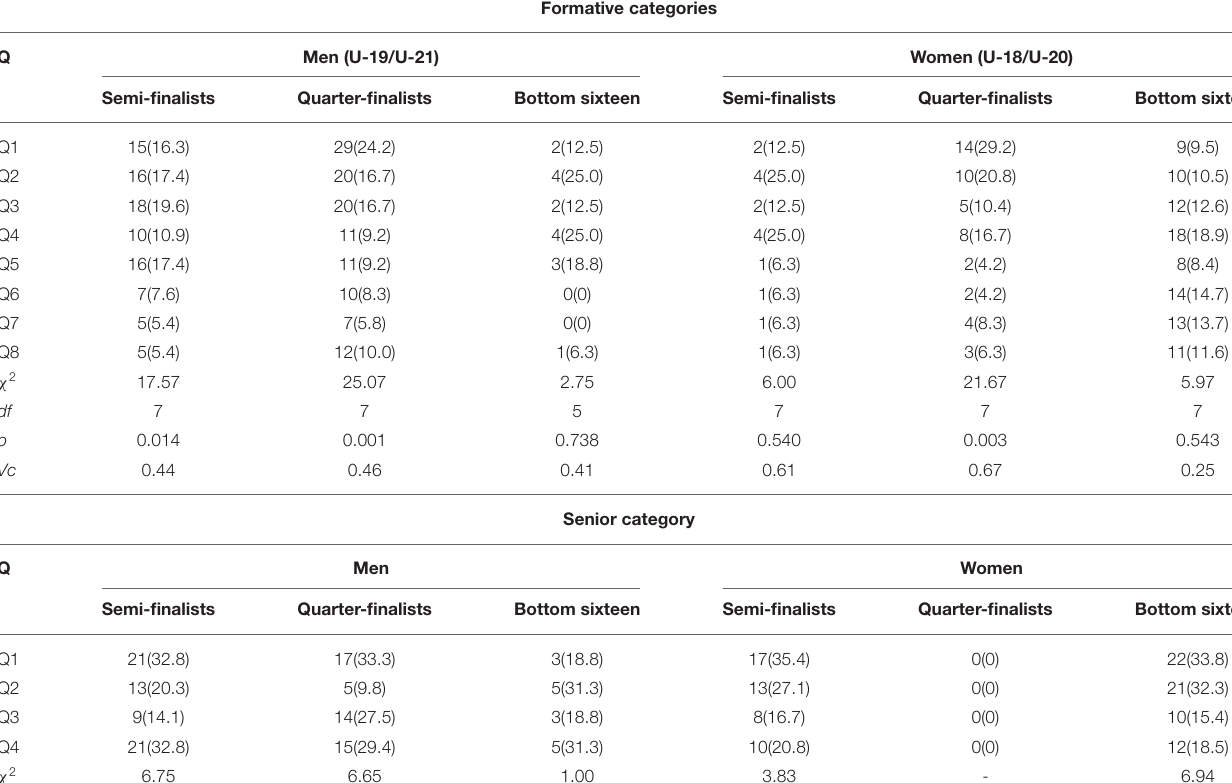
TABLE 4 | Quarterly distribution ( n and % ) of birth dates by gender and competitive level according to the final team